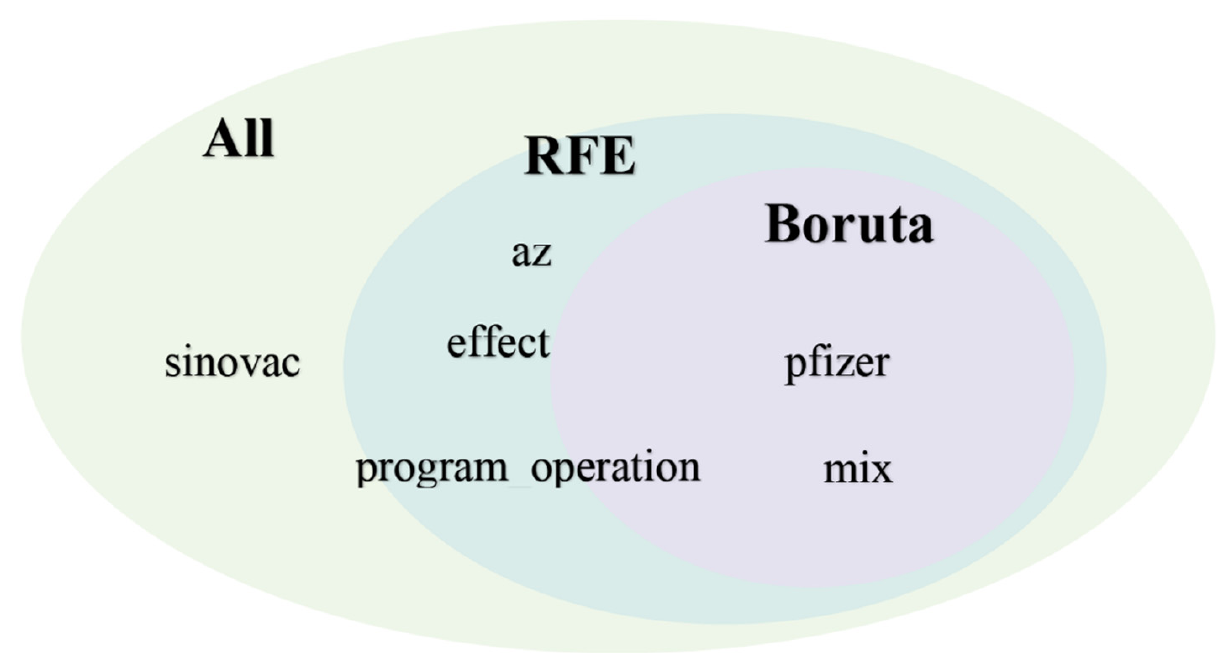
Figure 9. Venn diagram illustrating all, RFE, and Boruta determinants.